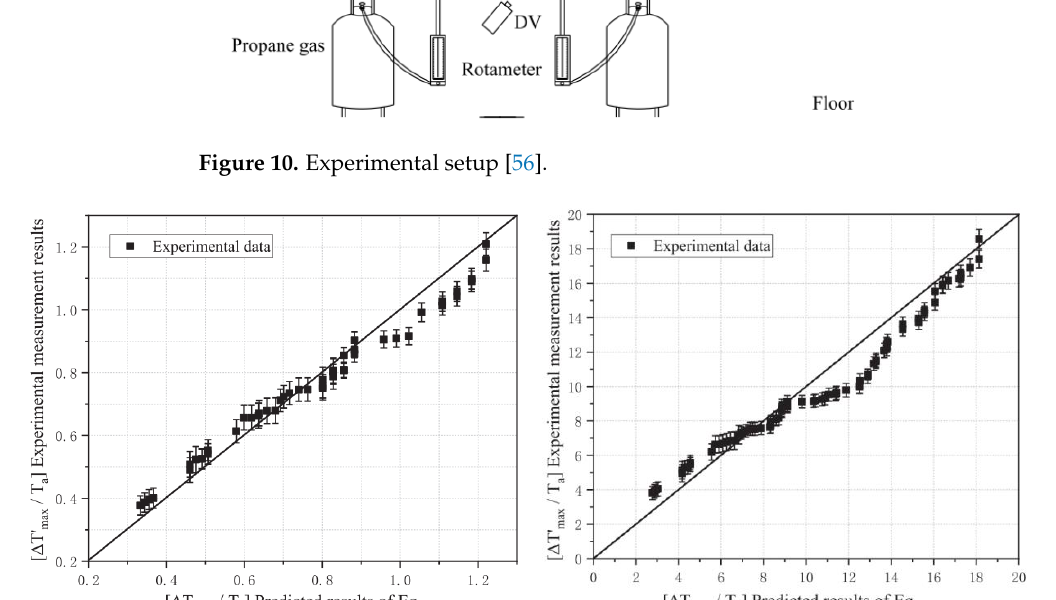
Figure 11. Comparison between the experimental results of maximum temperature beneath tunnel ceiling for double fire sources and equations [56].